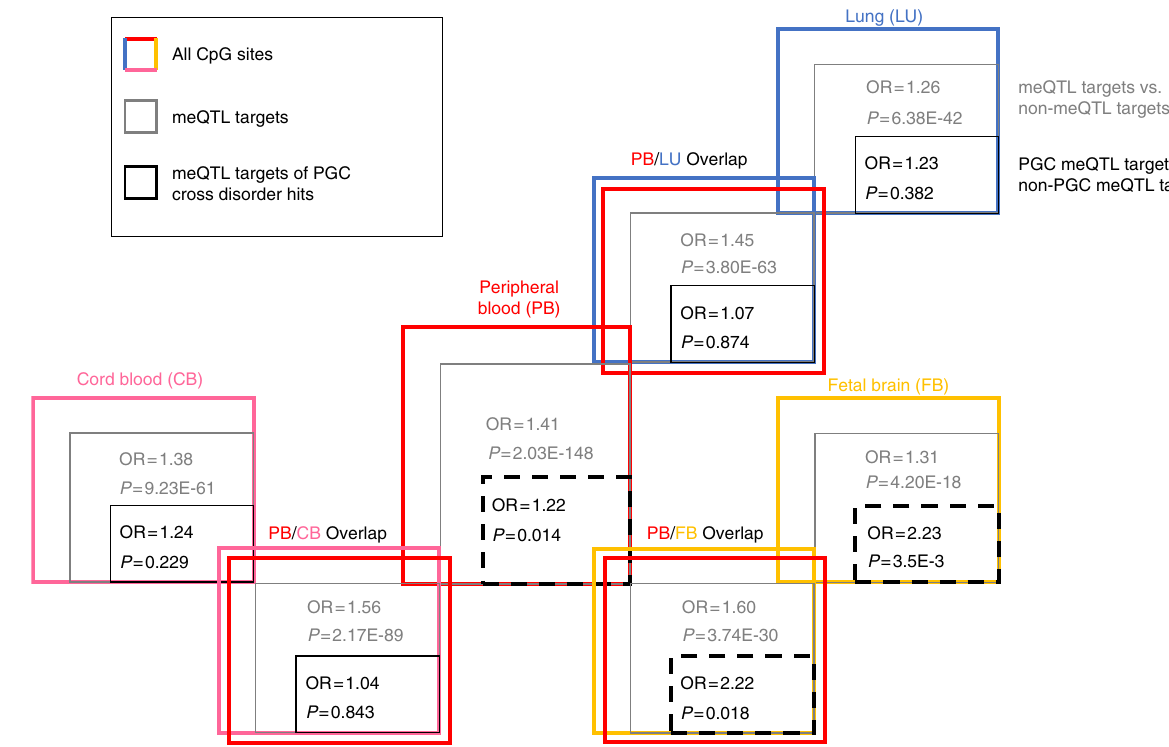
Fig. 2 Enrichment of meQTL target CpG sites in DNaseI hypersensitive sites. We identi fi ed the meQTL targets (at FDR 5% in peripheral blood, cord blood and lung, and past 1e – 08 P value threshold in fetal brain results) in peripheral blood, cord blood, fetal brain, and lung as well those meQTL targets that were present in the overlap of peripheral blood with the other three tissues. Odds ratio and P value in gray text represent enrichment fold statistic and P value from Fisher ’ s exact tests examining the tendency of meQTL targets to overlap with DHS sites compared to CpG sites that were not meQTL targets. Odds ratio and P value in black text represent enrichment fold statistic and P value from Fisher ’ s exact tests examining the tendency of meQTL targets of signi fi cant ( P value < = 1e – 04) SNPs from the PGC cross-disorder results or their proxies ( r 2 > = 0.8) to overlap with DHS sites compared to CpG sites that were not meQTL targets of the same SNPs. A full list of enrichment statistics and P value for both tests against a total of 181 cell-type-speci fi c DHS sites, cell-type-speci fi c chromatin marks, and transcription factor-binding sites is available in Supplementary Data 7 and